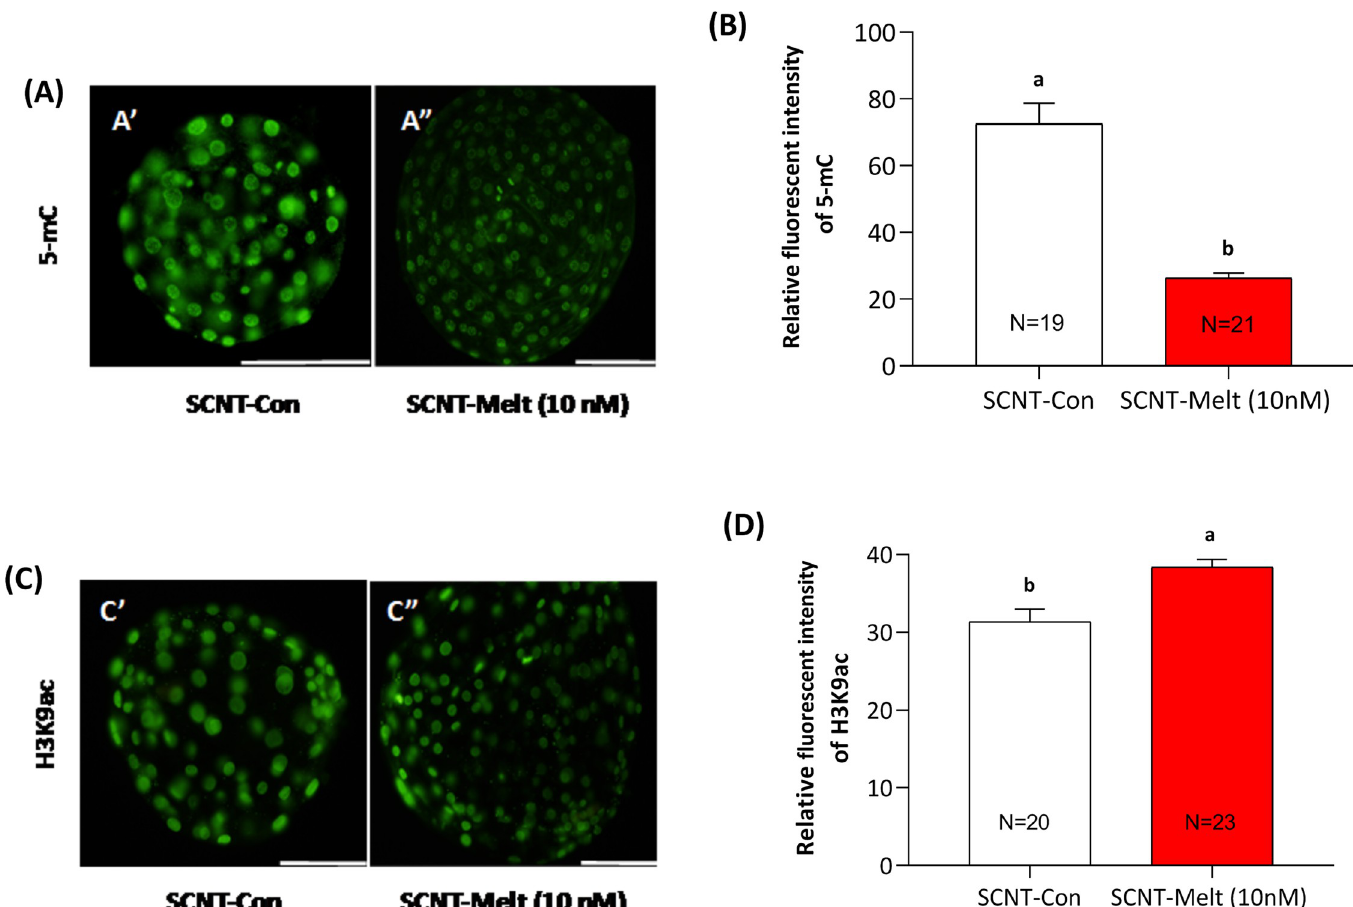
Fig 6. Global level of 5mC and of H3K9ac in ovine SCNT embryos. (A) Staining of 5mC in embryos in the SCNT, and SCNT-Melt (10 nM) groups at blastocyst stages. Scale bar, 100 μ m (B) Quantification of 5mC signal intensities in embryos in the SCNT, and SCNT-Melt (10 nM) groups at blastocyst stages. (C) Staining of H3K9ac in embryos in the SCNT, and SCNT-Melt (10 nM) groups at blastocyst stages. Scale bar, 100 μ m (D) Quantification of H3K9ac signal intensities in embryos in the SCNT, and SCNT-Melt (10 nM) groups at blastocyst stages. The data were shown as mean ± SEM. Values with different letters have a statistically significant difference ( P < 0.05). The experiments were performed more of three times. In each replication, n = 12–20 per group. SCNT, somatic cell nuclear transfer.